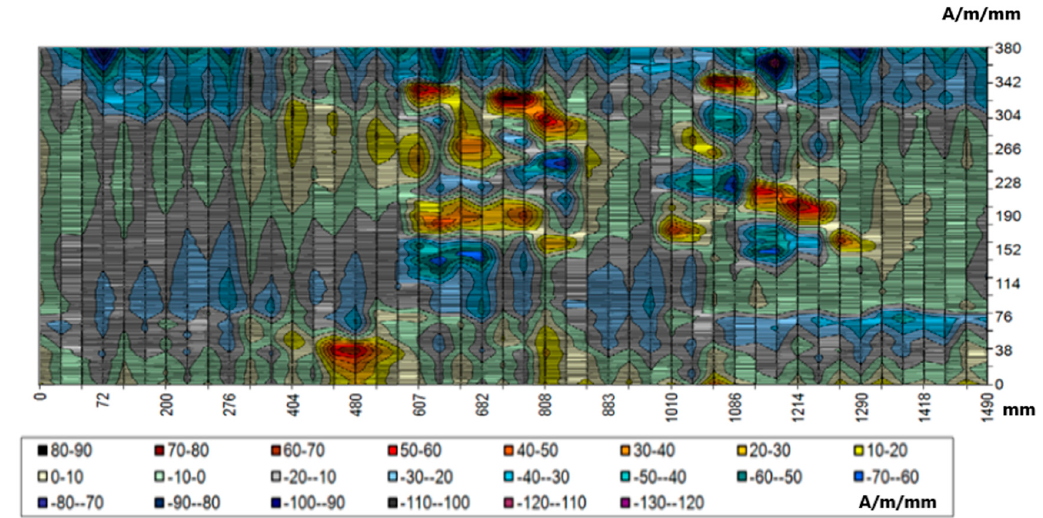
Figure 7. Distribution of tangential component Hpy for the selected area.